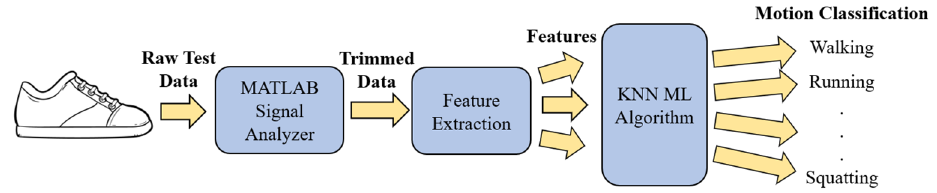
Figure 3. Diagram showing progression from raw data to classified movement.